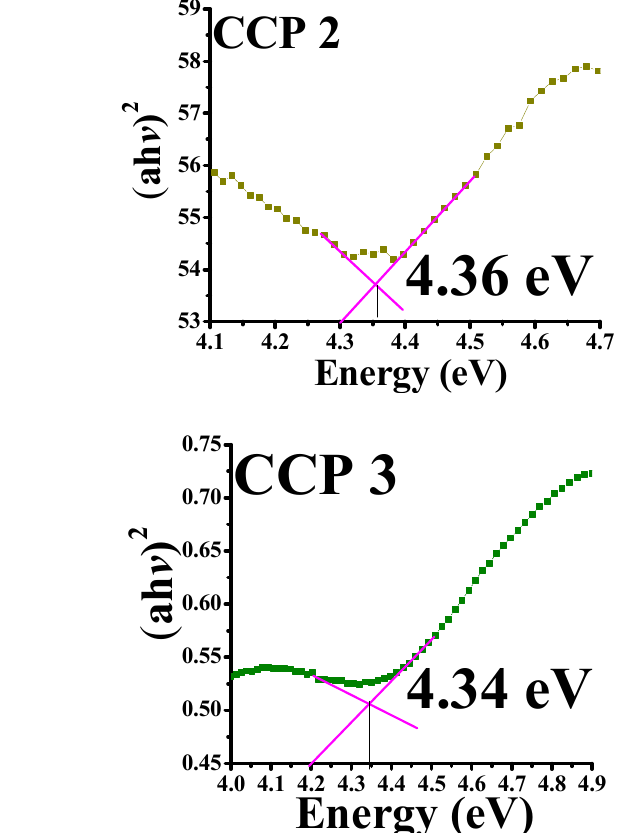
Table 2. The bandgap energies for the composites. Sr. No.